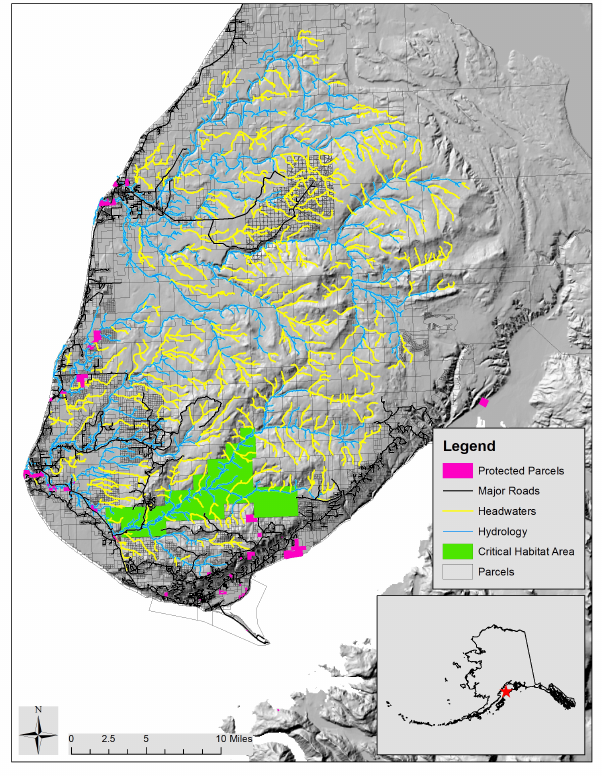
Fig. 2. Map showing the headwater streams (yellow) of the Kenai Lowlands region, Alaska, which compose a large proportion of the stream networks and are largely unprotected from development. Only a small proportion of the landscape has protected status (green), and much of the area is already platted, but not yet